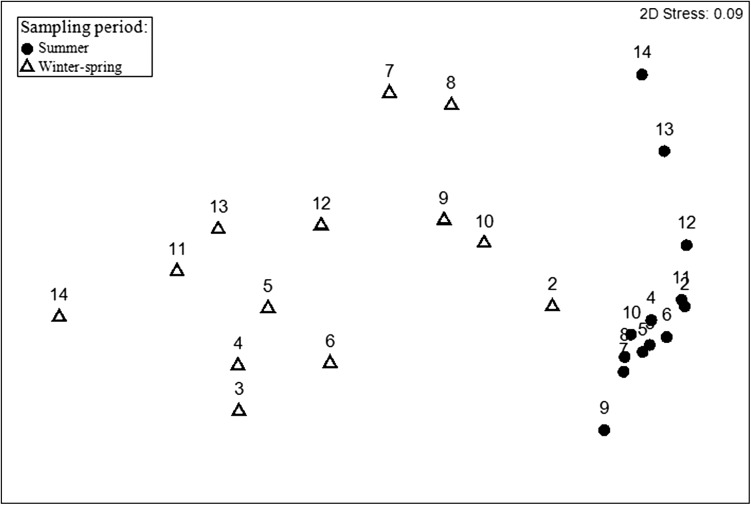
Non-multidimensional scaling ordination (NMDs) of phytoplankton community based on Bray–Curtis similarities of biomass during summer and winter–spring sampling periods. Numbers represent sampling stations.